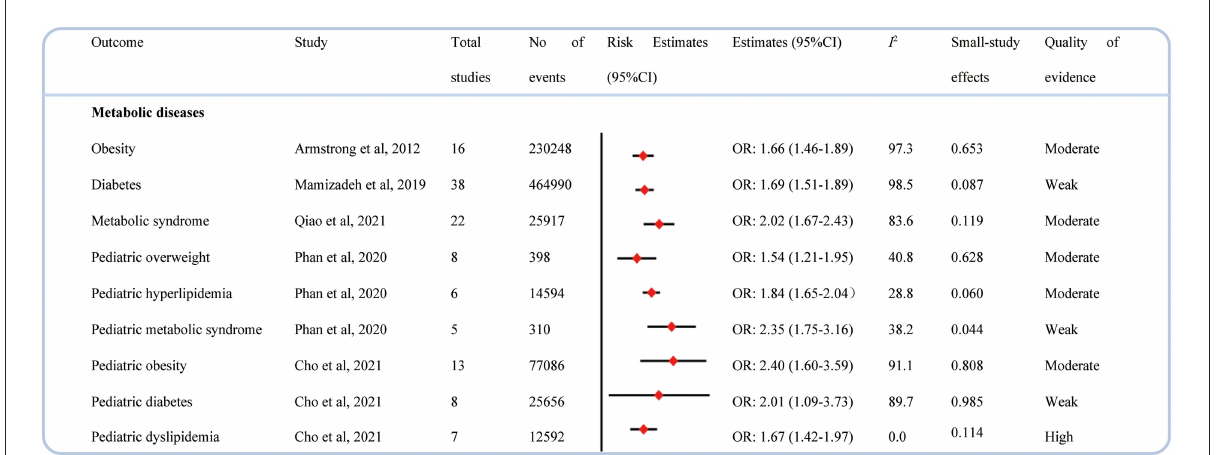
FIGURE6 Associations between psoriasis and metabolic diseases.